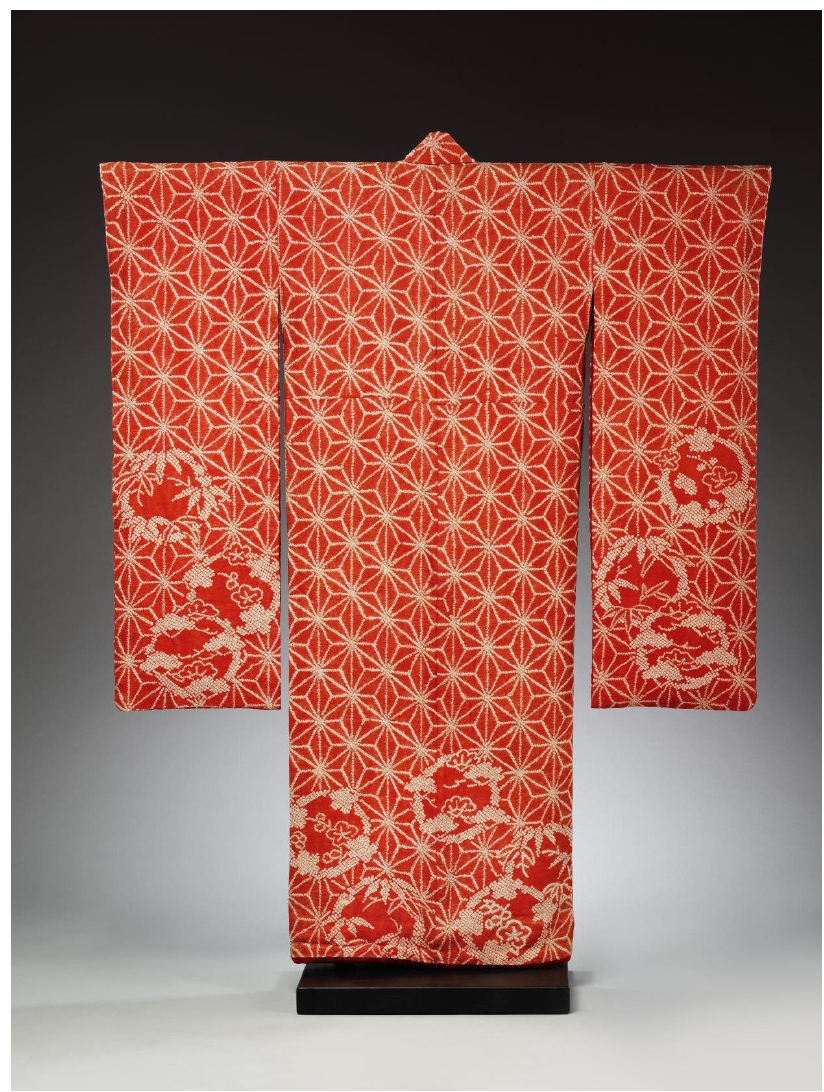
Figure 1. Kimono dyed with sa ffl ower; figured satin silk with tie-dyed decoration; Japan, 1800–1840. Figure 1 FE.32-1982. © Victoria and Albert Museum,